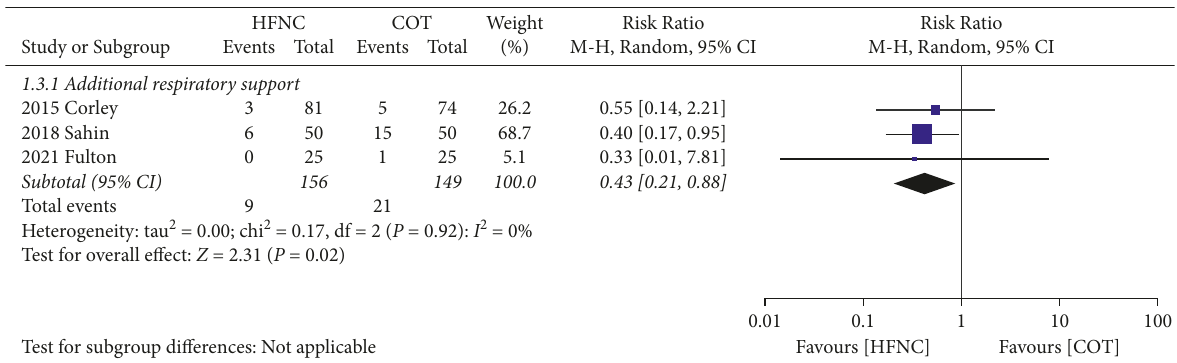
Figure 6: Forest plot comparing the need for additional respiratory support between HFNC and